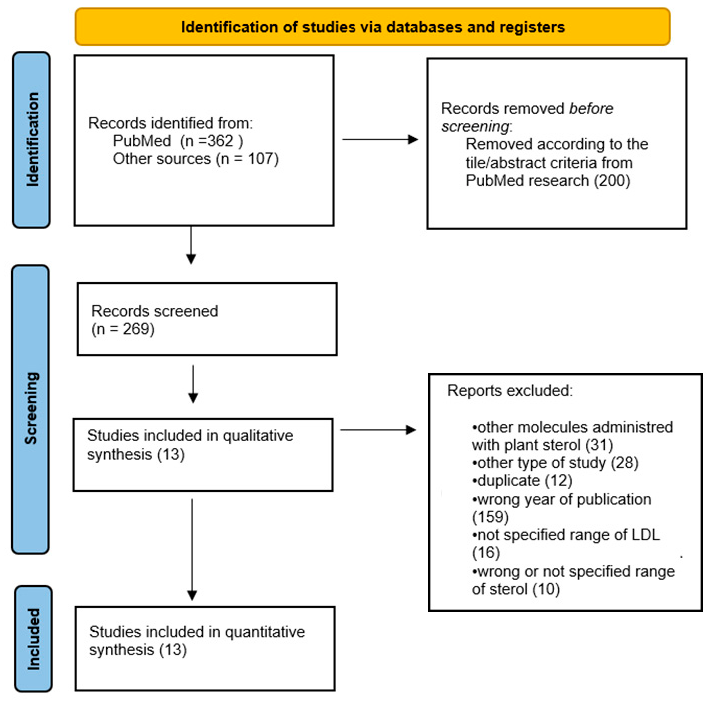
Figure 1. PRISMA flow chart of included